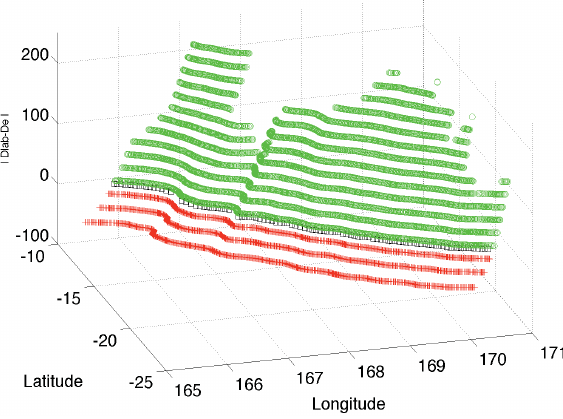
Fig. C1. Illustration of the intersection between a lithosphere thick- ness model of the overriding plate with a 3-dimensional slab model (coloured contours). Green colours reflect the subduction coupling zone, here conservatively taken as the entire intersection region be- tween the overriding and downgoing plates, and red colours reflect the slab surface below the lithosphere-asthenosphere boundary of the overriding plate. The black points define the edge of the cou- pling zone.